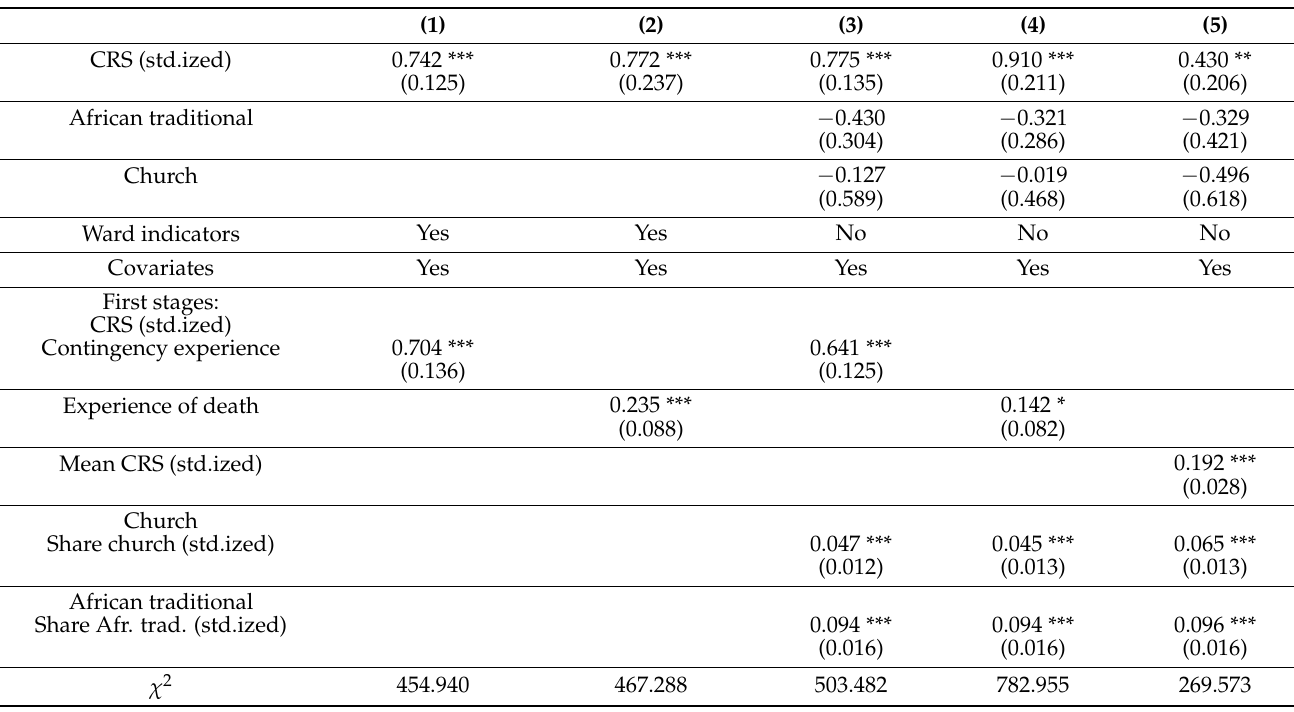
Table 7. Estimation results instrumental variable ordered probit